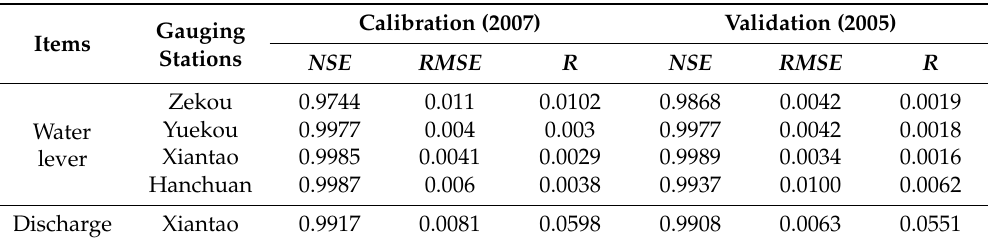
Table 2. Model evaluation results in calibration and validation